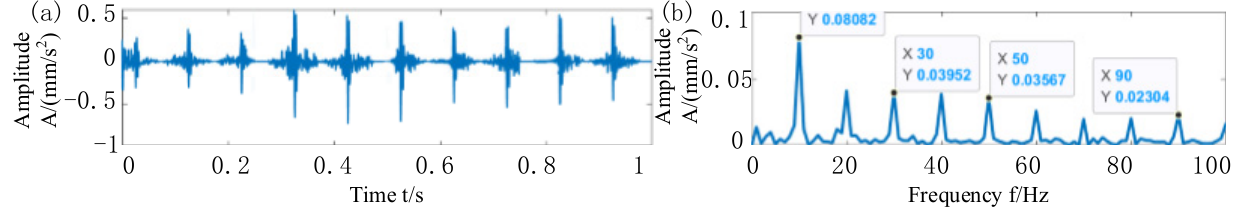
Figure 12. Denoising effect of K-SVD algorithm with improved termination criterion on filtered signal. ( a ) Time-domain waveform of denoised signal; ( b ) Denoised Signal Envelope Spectrogram.